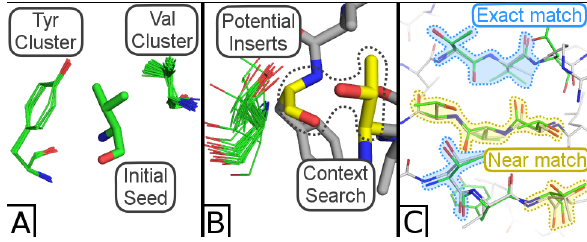
Figure 3. Incremental assembly of a motif. (A) An initial search for a guanidinium fragment reveals a cluster of nearby carboxylates. (B) Refining the search with one carboxylate from the results reveals a specific linker preference for both the aspartate and arginine involved in the salt bridge. (C) Adding the most common linker for arginine and repeating the search reveals that this salt bridge is part of an N-terminal capping motif. Search queries are represented as thick sticks and search results are shown as thin lines. Grey dashed lines highlight search queries and black dashed lines highlight clusters in the search results, which are filtered to show the specific residue fragments of interest and neighboring water molecules within 3.0 A˚ as red spheres. Search parameters and fragments listed in Table S2.